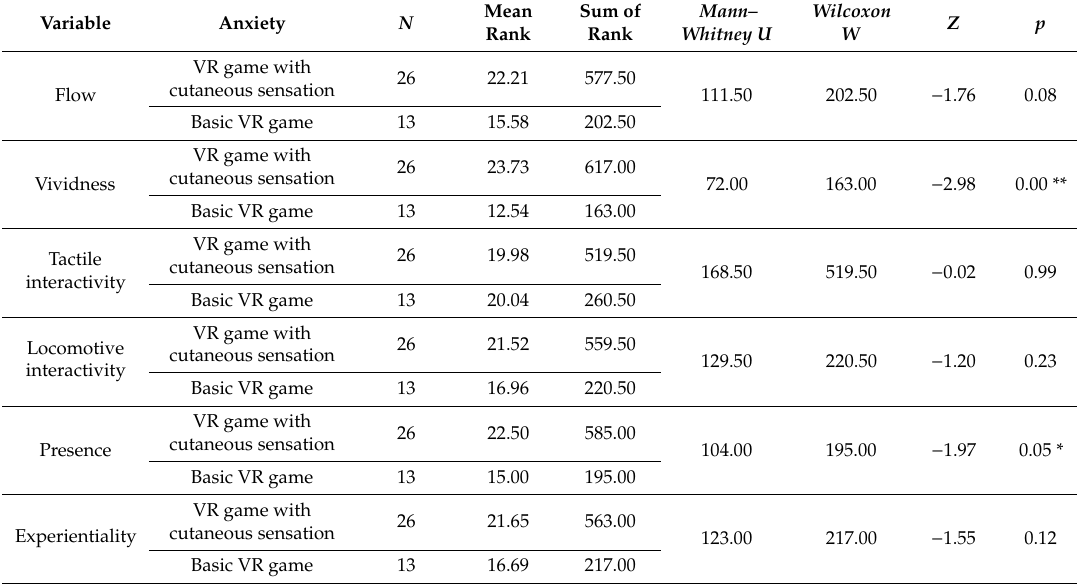
Table 6. Results of the Mann–Whitney U test analysis for the variables of the group of study participants who played the fire safety education VR game with cutaneous sensation and the group that played the basic fire safety education VR